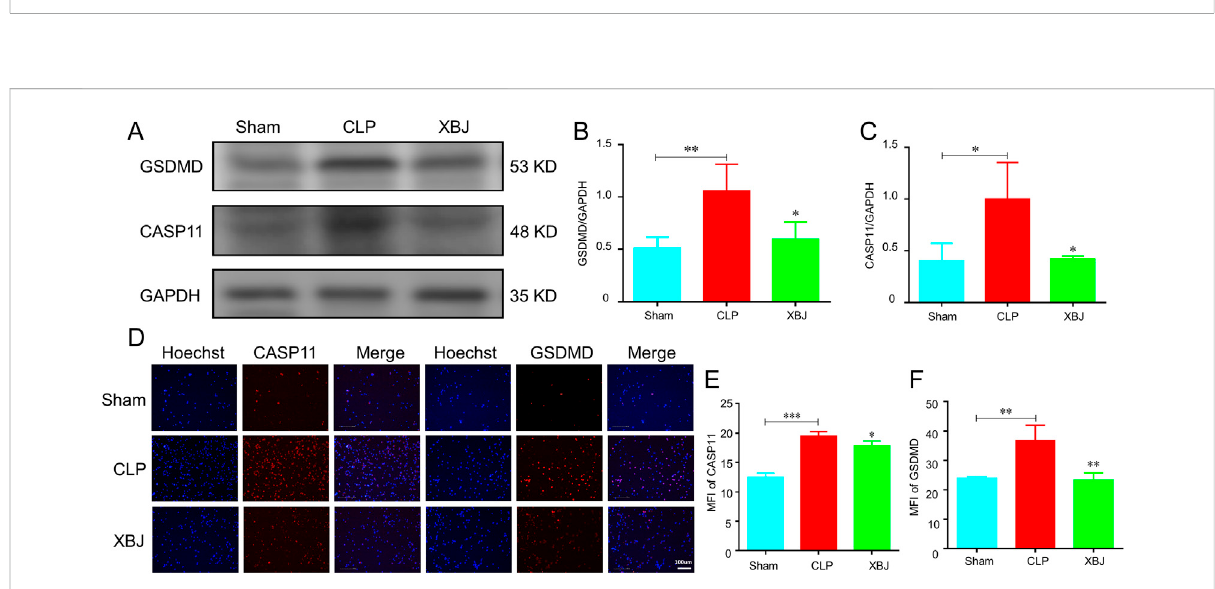
FIGURE 6 XBJreducedtheexpressionofcaspase-11andGSDMDinsepticmice.Thelungtissueswerecollectedat24 hafterCLP. (A – C) .Theexpressions of GSDMD and caspase-11 were determined with Western blot (A) and quanti fi ed results (B,C) , respectively ( n ≥ 3) (D – F) . The neutrophils in lung tissues were isolated and puri fi ed at 24 h after CLP. The expressions of caspase-11 and GSDMD were detected by immuno fl uorescent assay as describedinthemethods (D) .therepresentativeimagesofimmuno fl uorescentassays (E,F) .Thequanti fi cationofcaspase-11 (E) andGSDMD (F) expressions in neutrophils isolated from lung tissues. N > 3/group. The values were indicated as mean ± SD. * p < 0.05, ** p < 0.01, *** p < 0.001, compared with the CLP